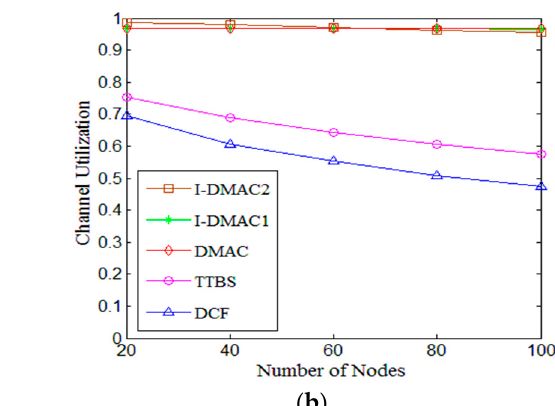
Figure 8. Fairness index under multi-rate scenario. In summary, I-DMAC1 and I-DMAC2 are not as good as TTBS in term of airtime fairness. However, they obtain better throughput, utilization, and delay. In addition, except for delay, I-DMAC2 always performs better performance than I-DMAC1. Therefore, I-DMAC1 is suitable for some delay-sensitive applications and I-DMAC2 can provide the better system throughput and airtime fairness for the other applications. 6. Conclusions Legacy DCF coordinates the channel access among multiple nodes by employing a simple distributed control mechanism. However, with various multimedia applications being deployed, this pure distributed access control becomes hard to meet the requirements of these applications and it hinders the further improvement of throughput. In this paper, we present a decoupling DMAC algorithm by partitioning the channel access into contention period and data transmission period, which inherits the merit of distributed random channel access and enables nodes to perform a collision-free data transmission. We present the algorithm procedure and framing details and validate the effectiveness of this channel decoupling mechanism by numerical analysis. In addition,